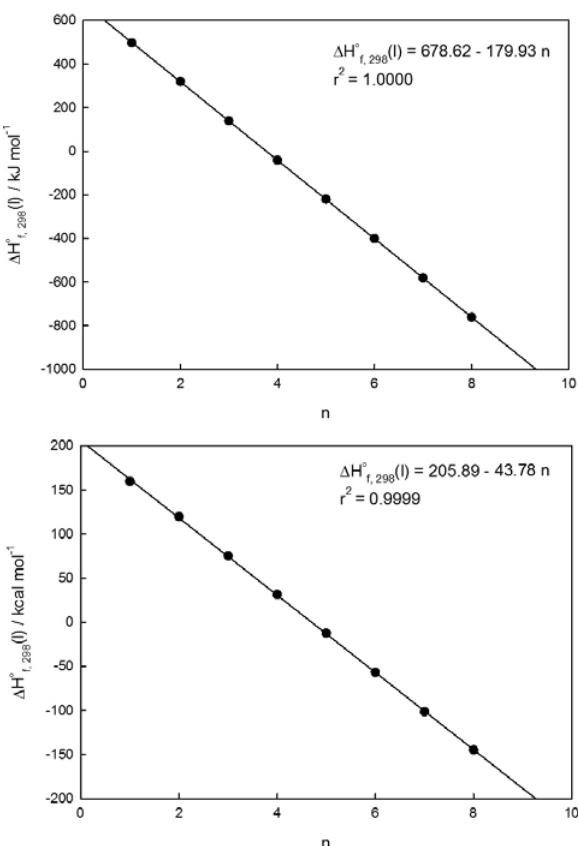
Figure 2. Plot of condensed-phase standard molar enthalpies of formation vs. number of carbon atoms in alkyl group for ATs at 298 K, obtained using formation reaction route at B3LYP/6-31G(d,p) and HF/6-31G(d,p) levels of theory (up and down,